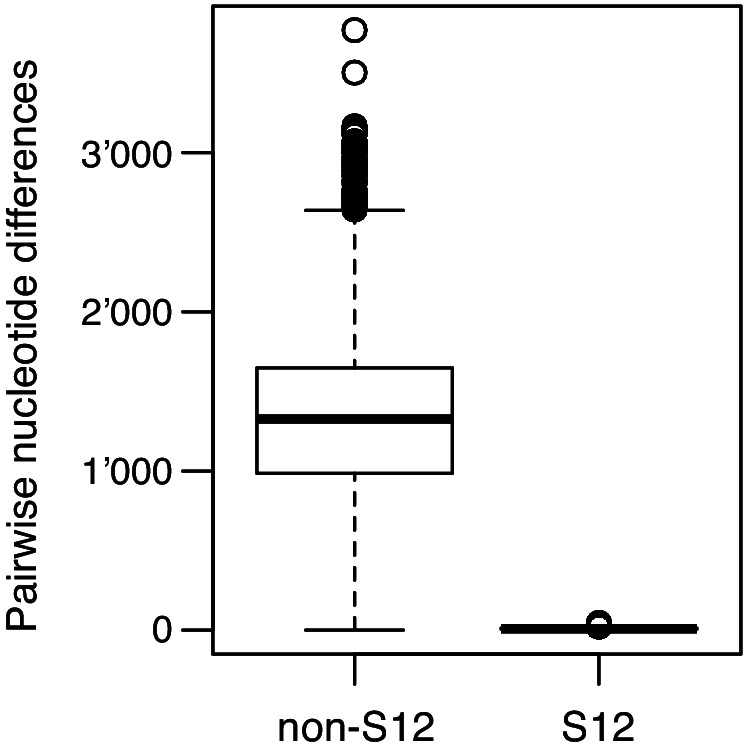
Pairwise genome-wide nucleotide differences between S12 and non-S12 isolates.